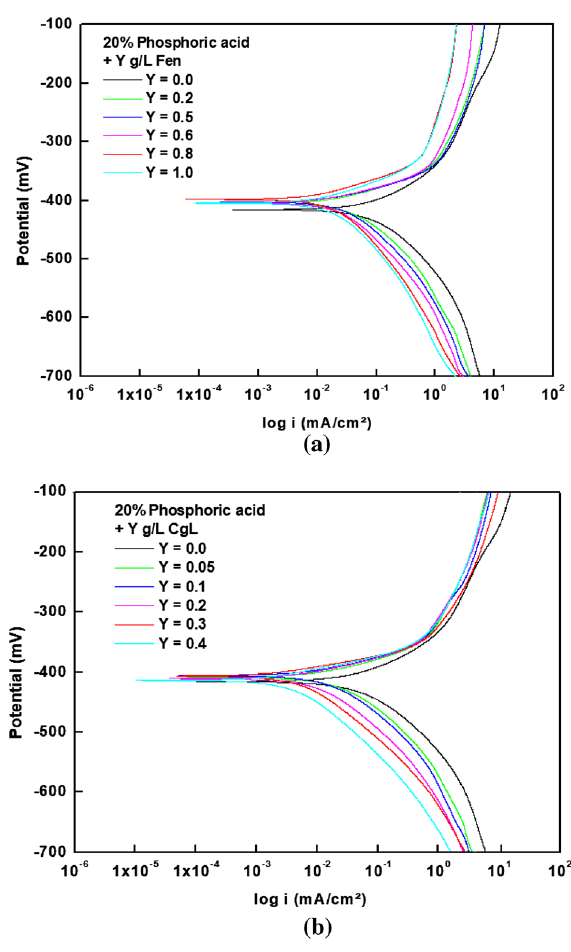
Figure 3. Potentiodynamic polarization plots of steel in 20% phosphoric acid in the absence and presence of ( a ) Fen extract and ( b ) CgL